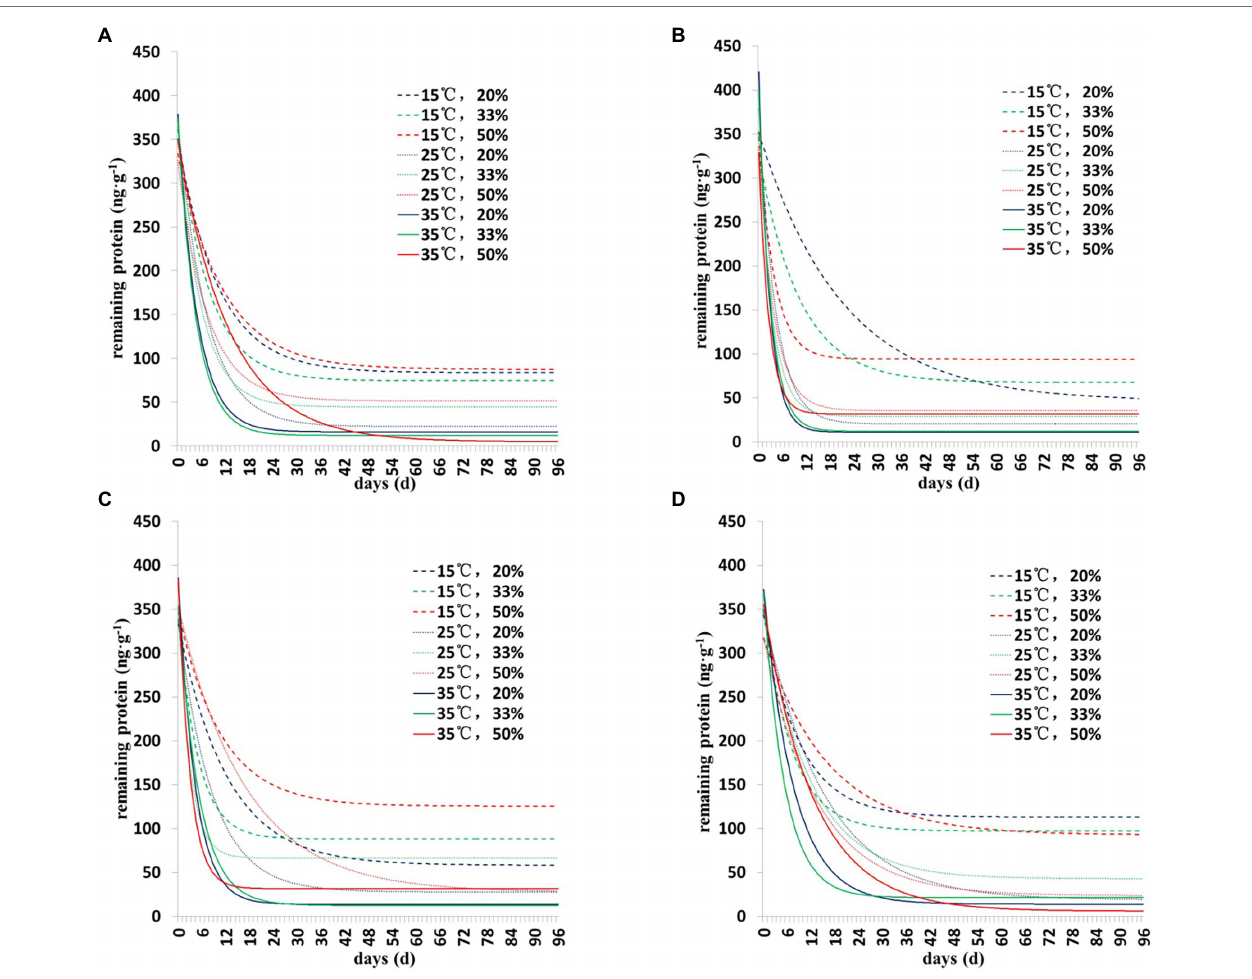
FIGURE 2 | The degradation dynamics of Cry1Ah protein in the soil in four soil types under different environmental conditions. The data were calculated following degradation model Y = Y 0 + ae − b * X . (A) Gongzhuling, (B) Jinan, (C) Beijing, and (D) Zhengzhou; temperature (15 ° C, 25 ° C, and 35 ° C), water content (20, 33, and 50%).